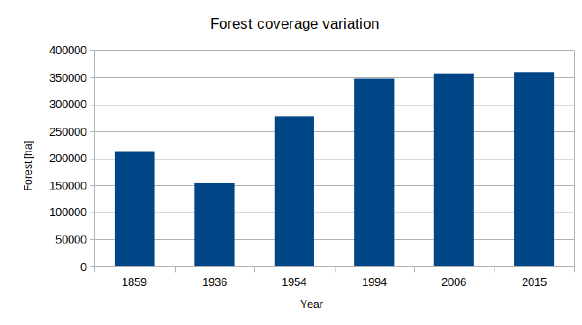
Figure 14. Forest coverage evolution in the Trentino region from 1859 to 2015.